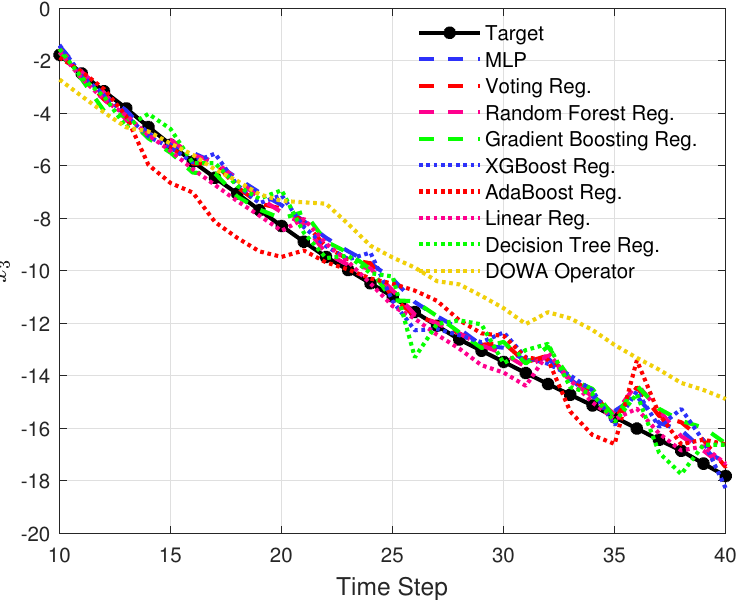
Figure 15. Fusion results for one Monte Carlo simulation for state 3 (zoomed